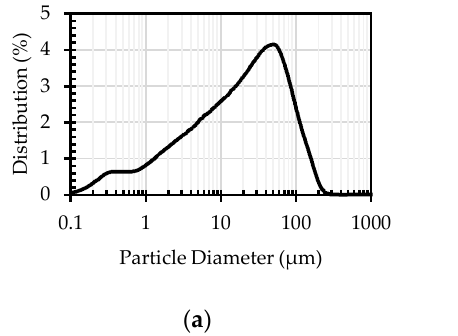
Figure 3. Particle size distribution: ( a ) MIBA ( b ) FA.